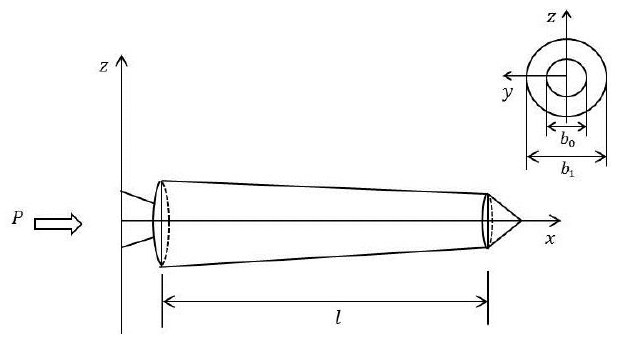
Figure 1. Simplified nonuniform rocket body subjected to constant thrust.